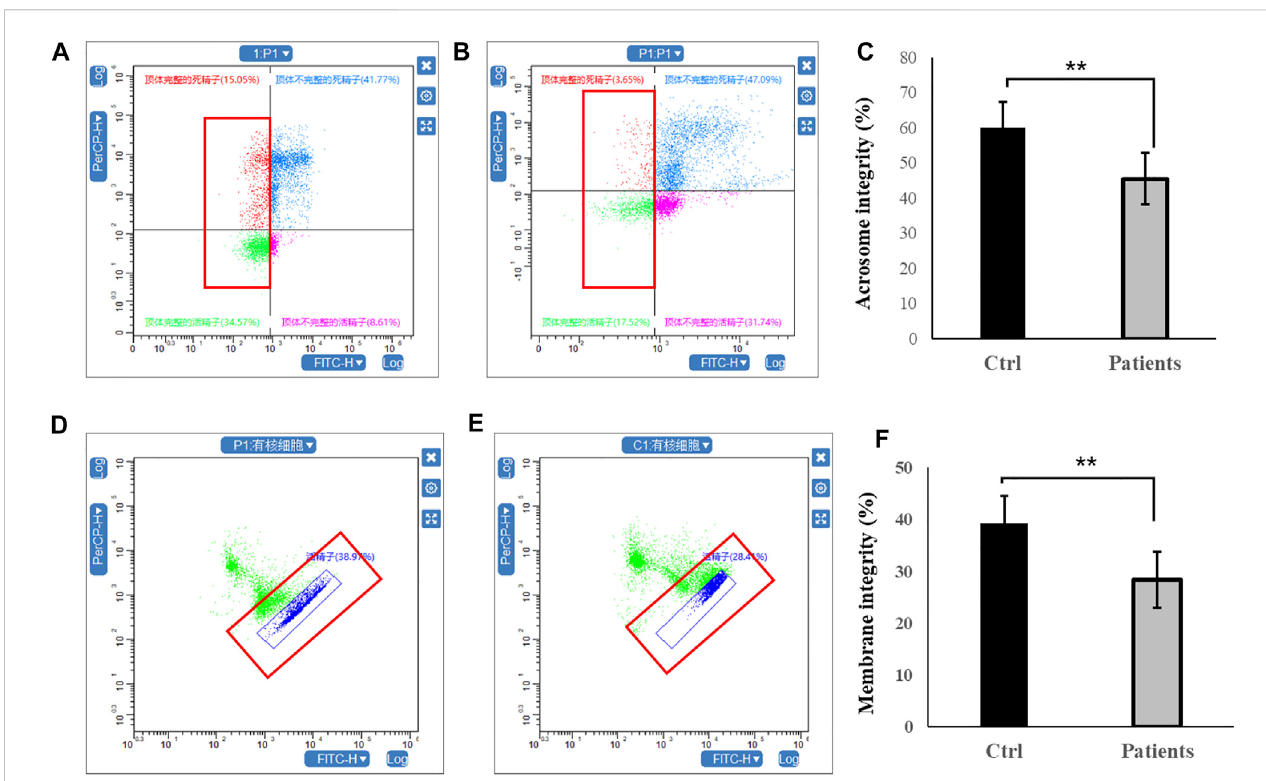
FIGURE 1 Flow cytometry analysis of acrosome integrity and membrane integrity within human spermatozoa. (A – C) , acrosome integrity levels. (D – F) , membrane integrity. All data are displayed as means ± s.e.m. (** p < 0.01, Student ’ s t -test).